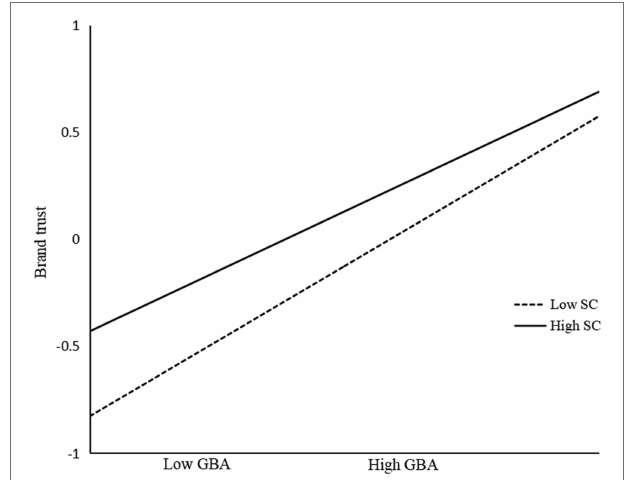
FIGURE 2 | Moderating effects of self-concept